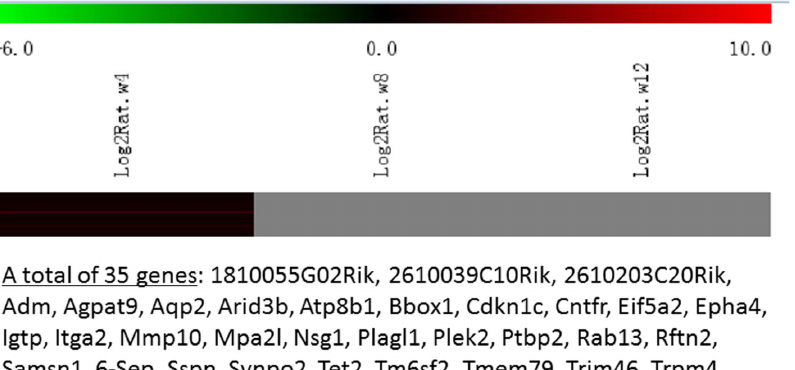
Figure 5. The Heat Map and the list of genes which were up-regulated at the early stage (4 weeks of age). There were a total of 35 genes in the list.